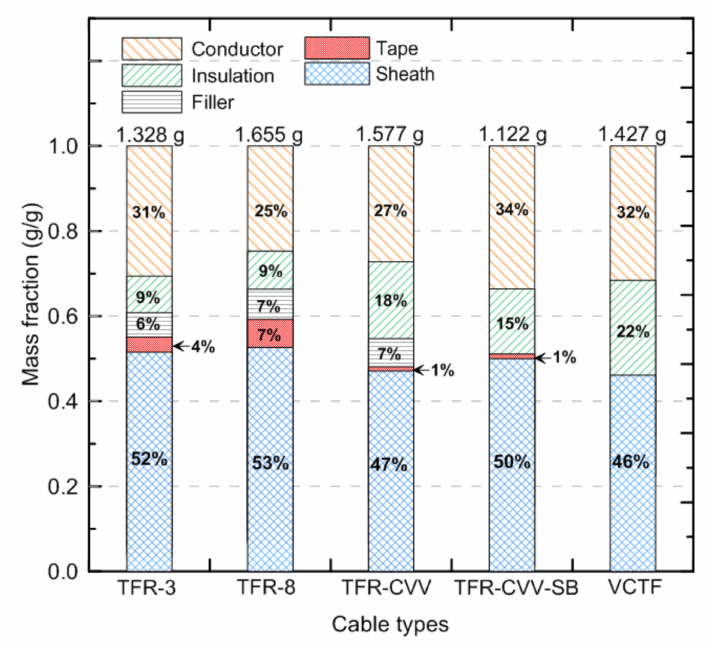
Figure 2. Comparison of the mass fraction of multiple materials, except conductors in the